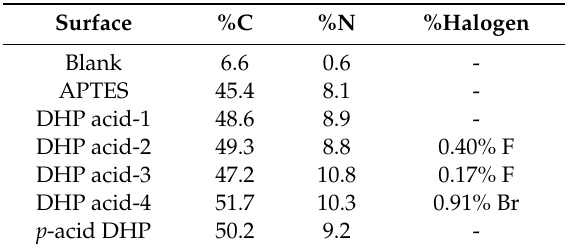
Table 1. XPS elemental composition of blank, (3-Aminopropyl)triethoxysilane (APTES) and DHP-modified glass surfaces.